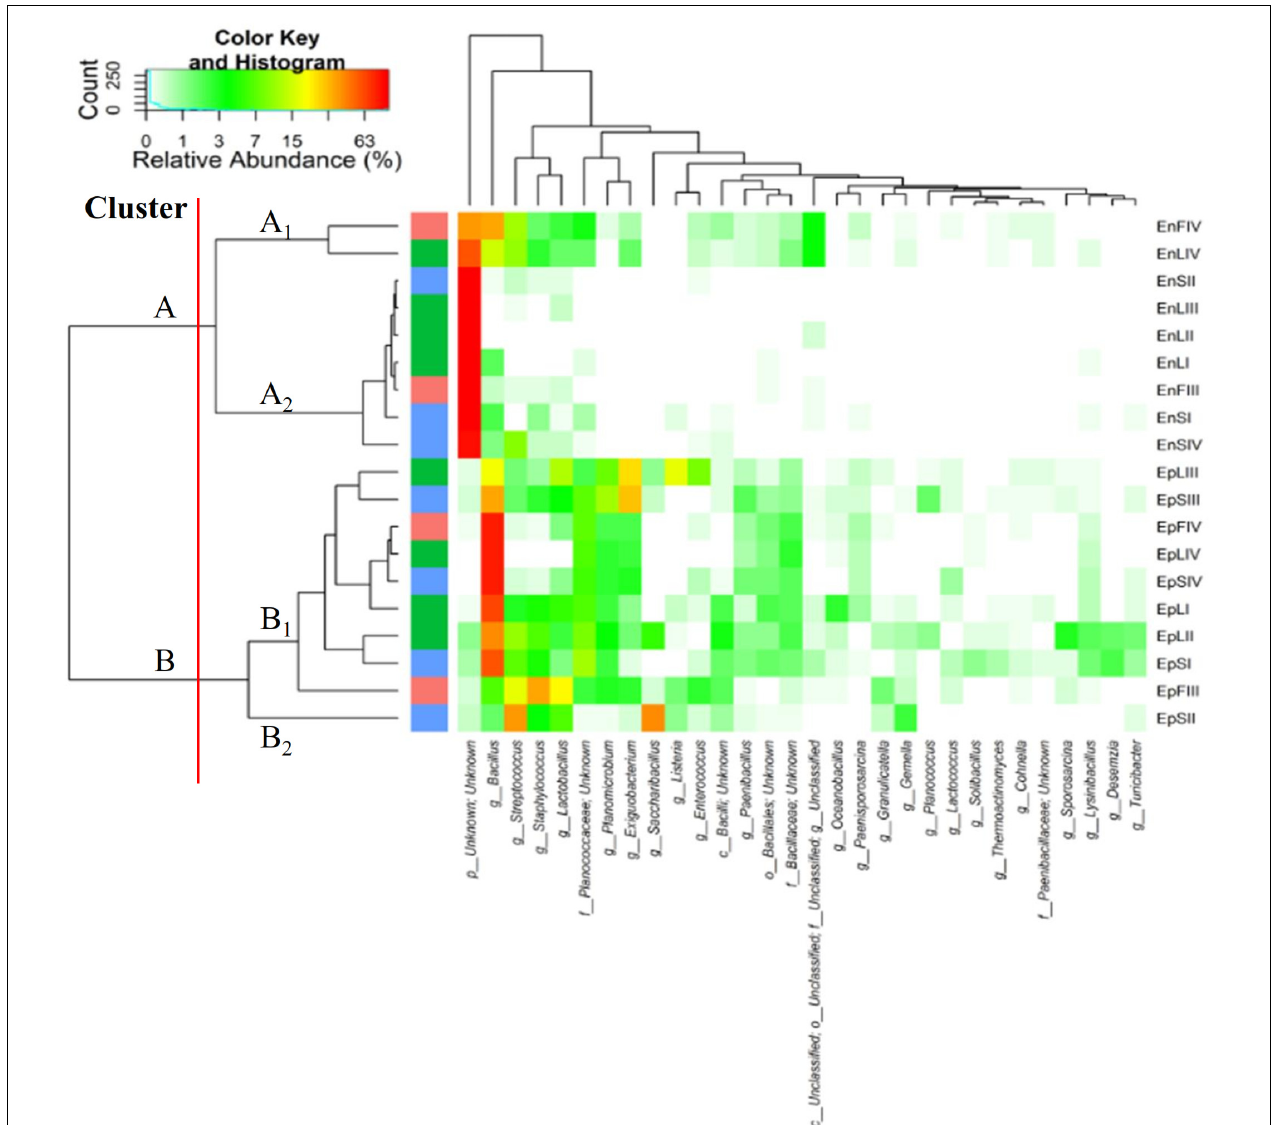
FIGURE 4 | Pseudo heat map summarizing the relative abundances of the 30 most dominant genera in DNA samples directly extracted from epiphytic (Ep) and endophytic (En) Firmicutes found on leaves, stems and flowers of Origanum vulgare L. plant during the early vegetative (I), late vegetative (II), blooming (III) and full-flowering (IV) stages. The color key defines the percentages of OTUs in the samples.